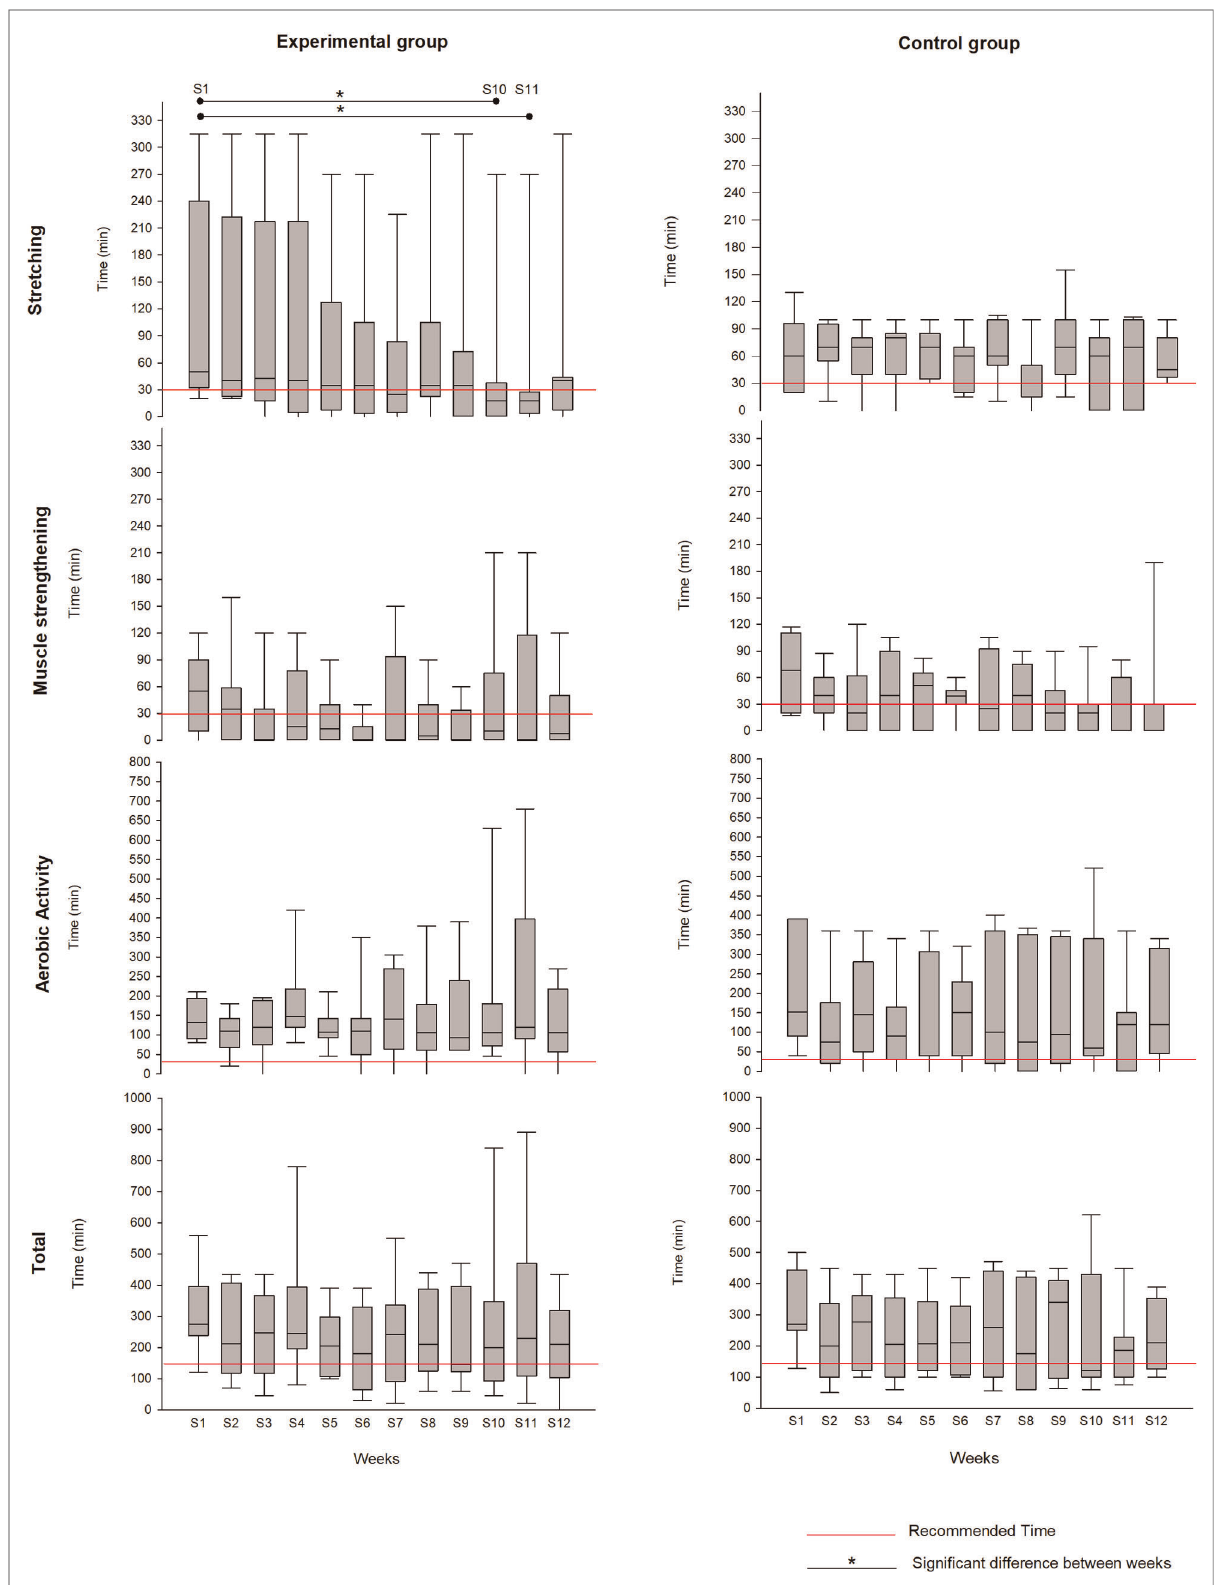
FIGURE 2 Practice (median or mean) of different types of activities, for each group, during the 12 weeks of the home